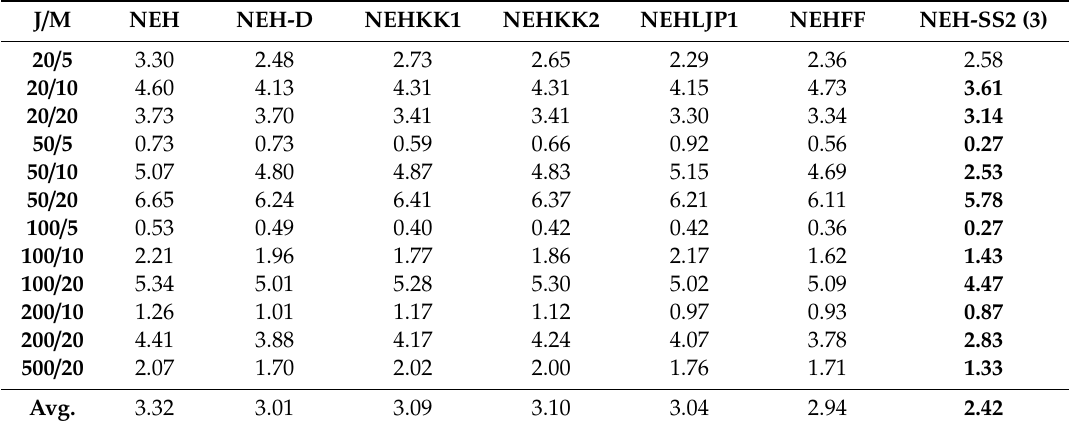
Table 5. ARPD values of di ff erent improvement methods compared to Taillard’s